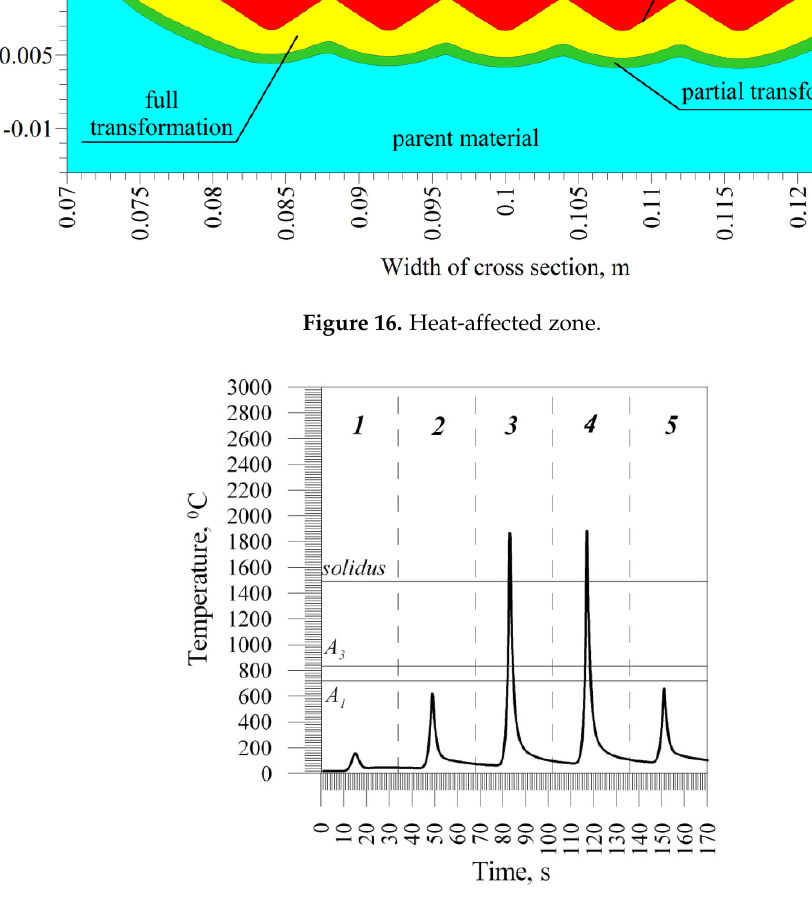
Figure 17. Thermal cycles at point with coordinates (0; 0.104 m).